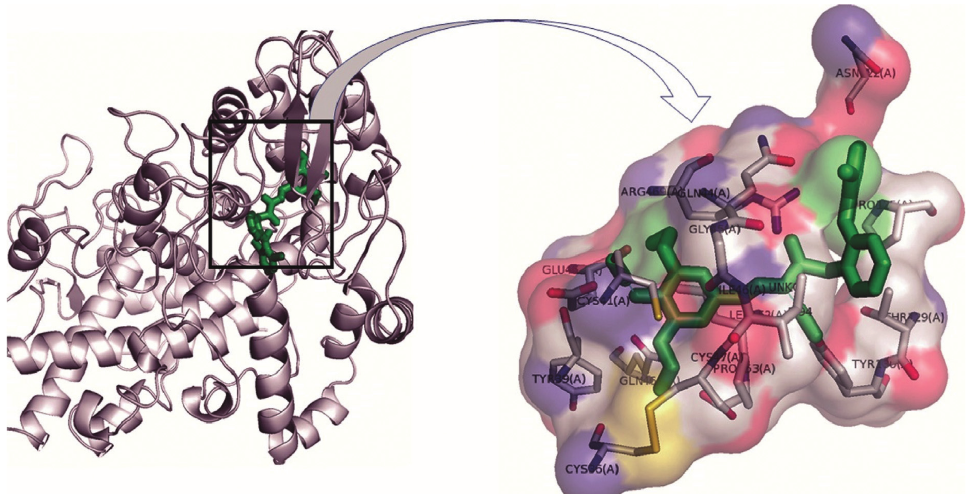
Figure 3: Binding of compound 8 with COX-1 protein. In zoom-in subset, the amino acid residues which are involved in the binding with the drug can be